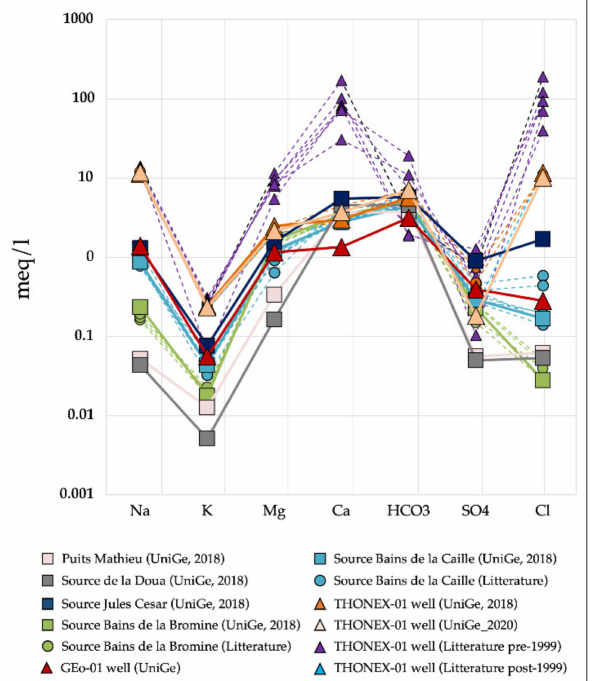
Figure 4. Schoeller plot of the analyzed dataset including literature data from previous